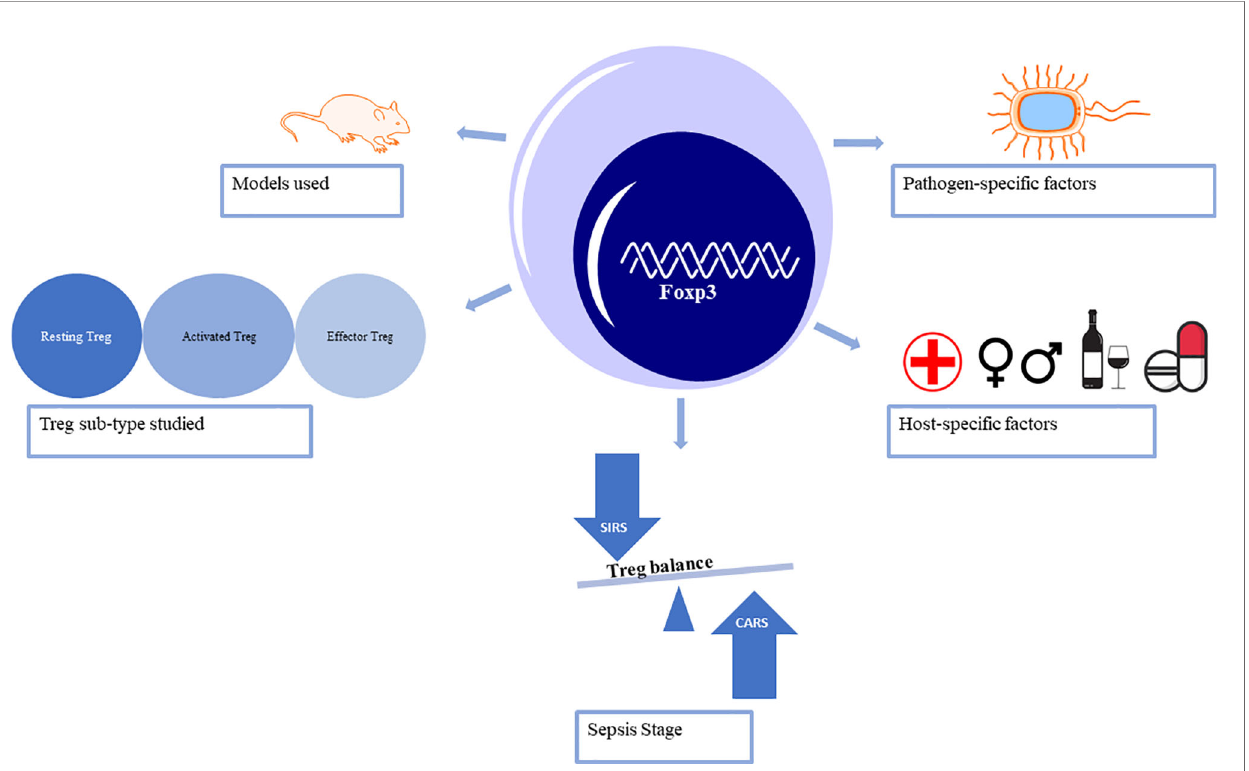
FIGURE 1 | Factors that lead to the controversy surrounding the role of regulatory T cells in